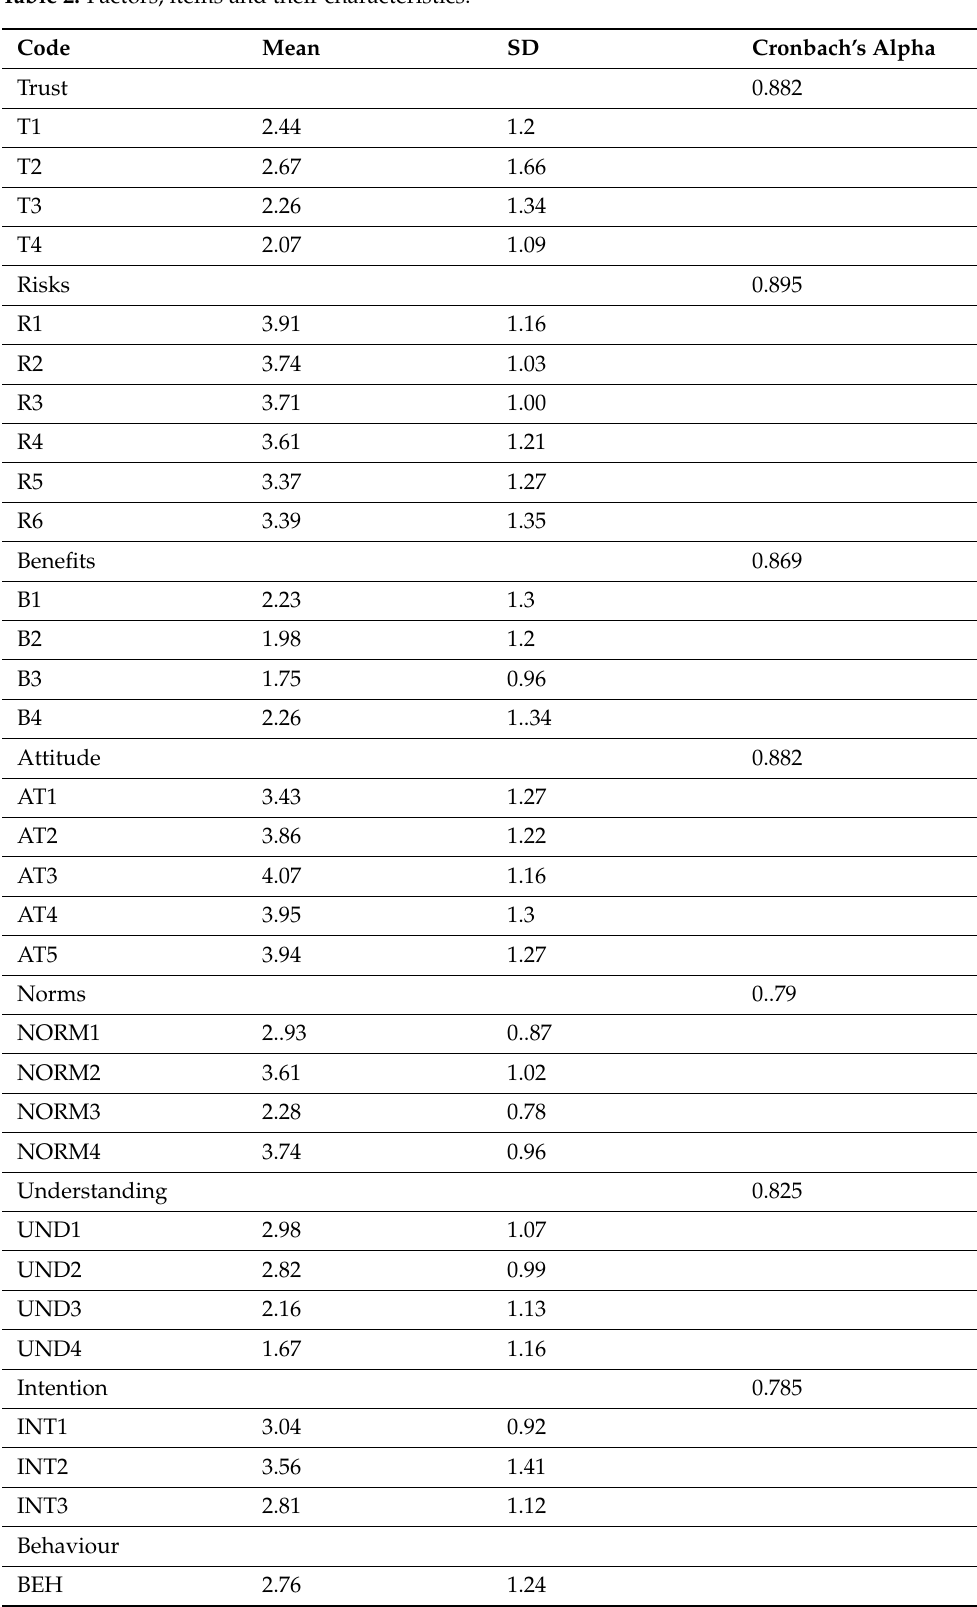
Table 2. Factors, items and their